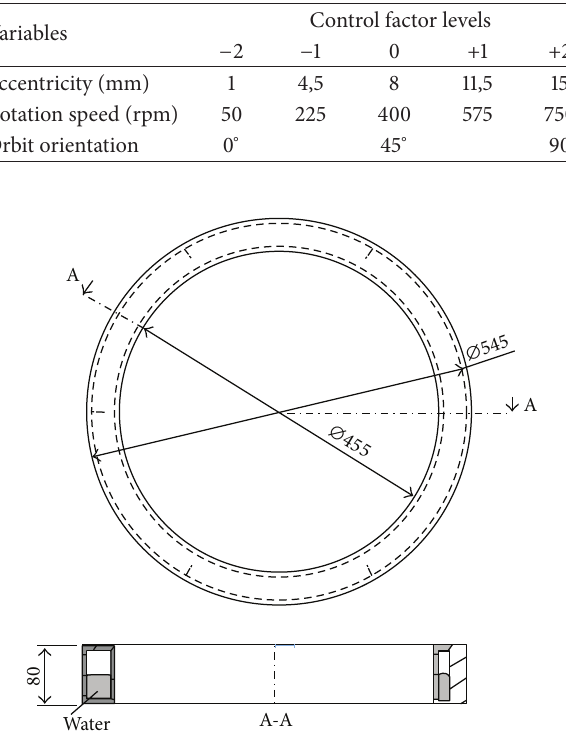
Figure 2: Schematic of simplified LeBlanc